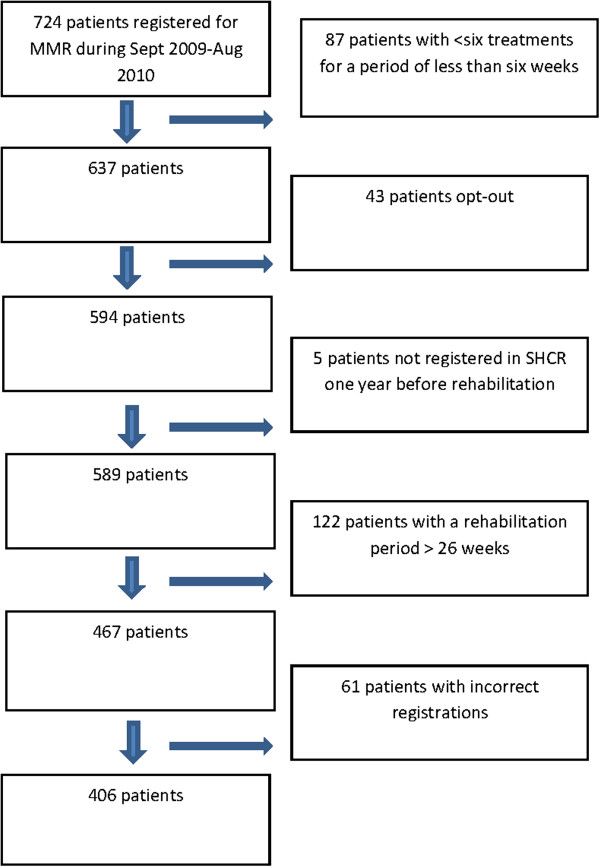
Flowchart on inclusion and exclusion in the cohort.